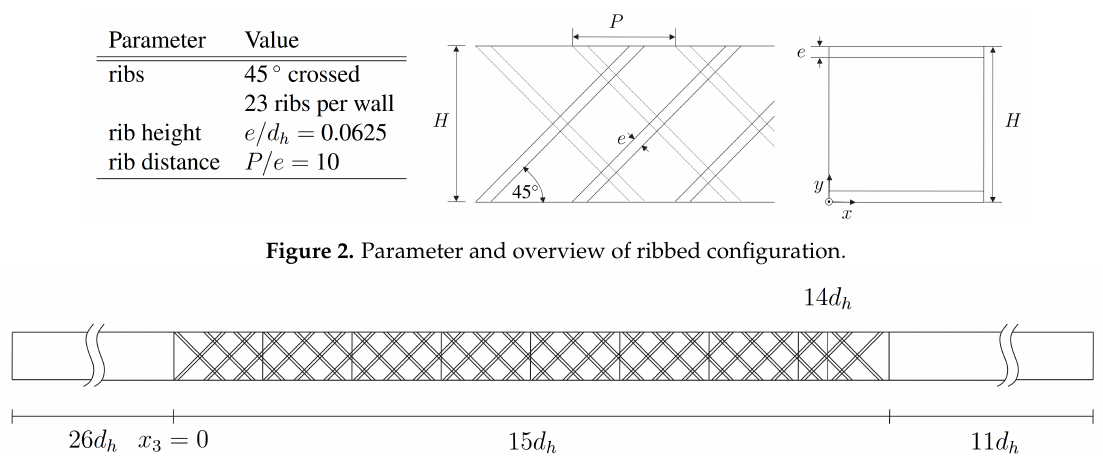
Figure 3. Overview of ribbed configuration and